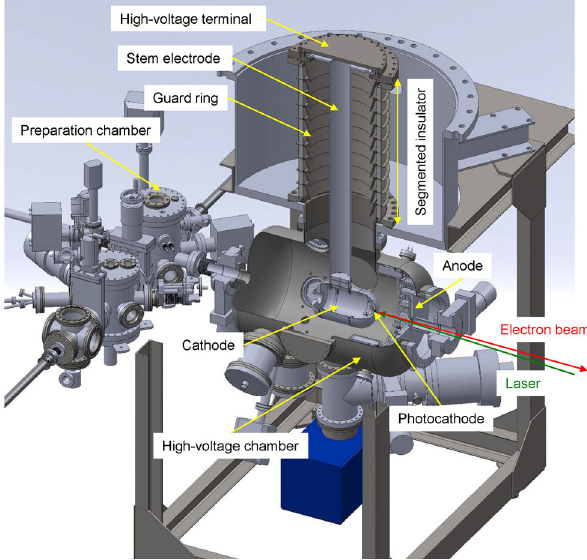
FIG. 1. Schematic illustration of the 500 kV dc photoemission gun developed at